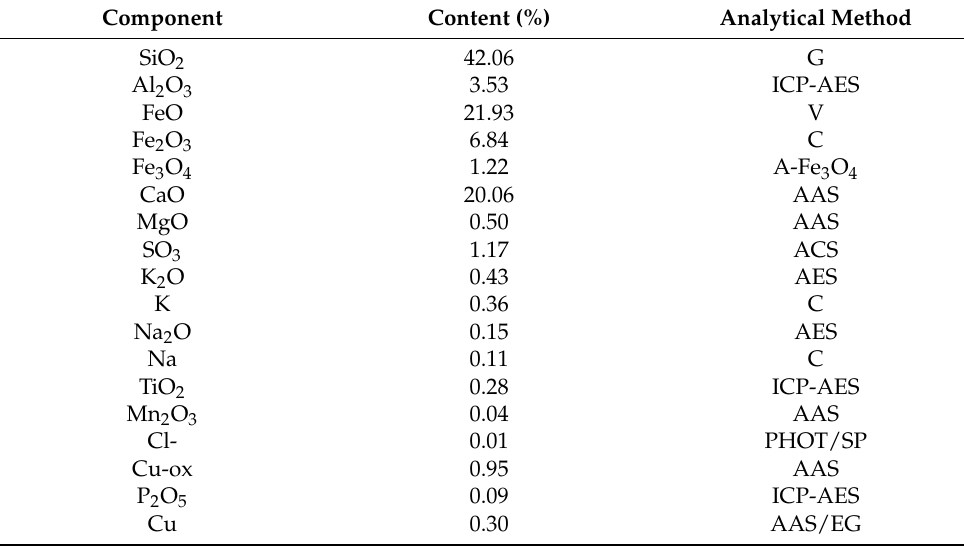
Table 1. Chemical composition of copper slag aggregate (CSA).